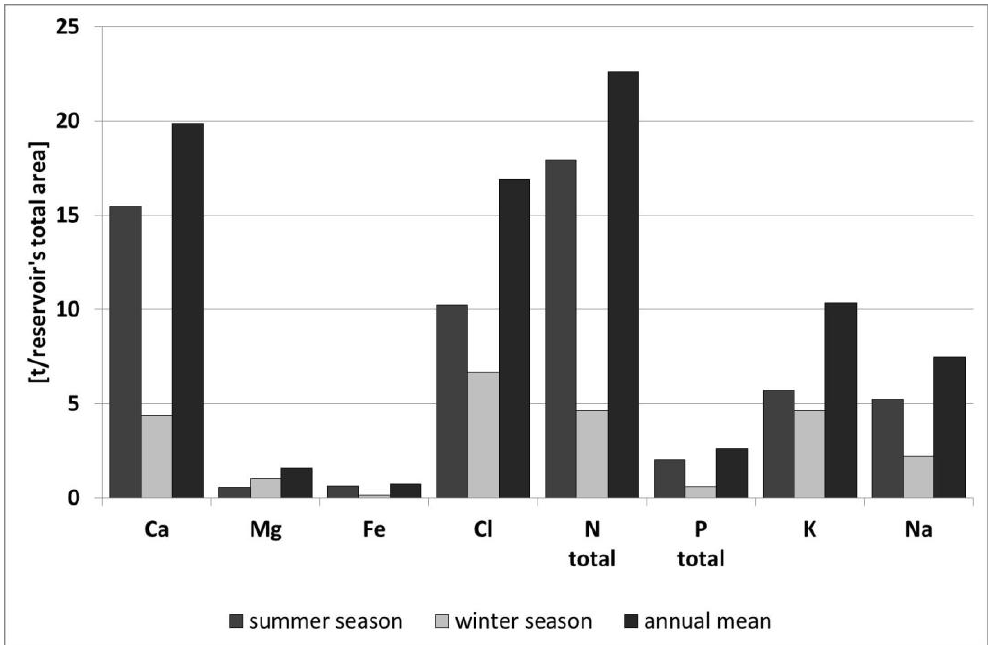
Fig. 11. Mean annual, and mean seasonal, pollutant load carried with precipitation onto the surface of Goczałkowice Reservoir in 2011-2012 in